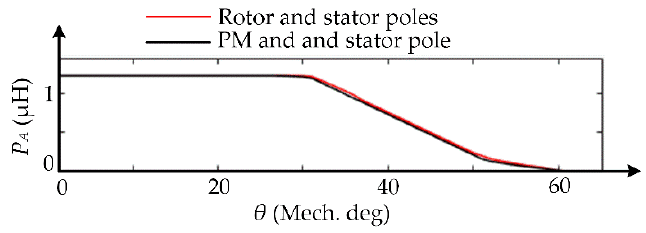
( f ) Figure 3. Rotor positions at different regions: ( a ) Region one; ( b ) Region two; ( c ) Region three; ( d ) Region four; ( e ) Region five; ( f ) Region six.